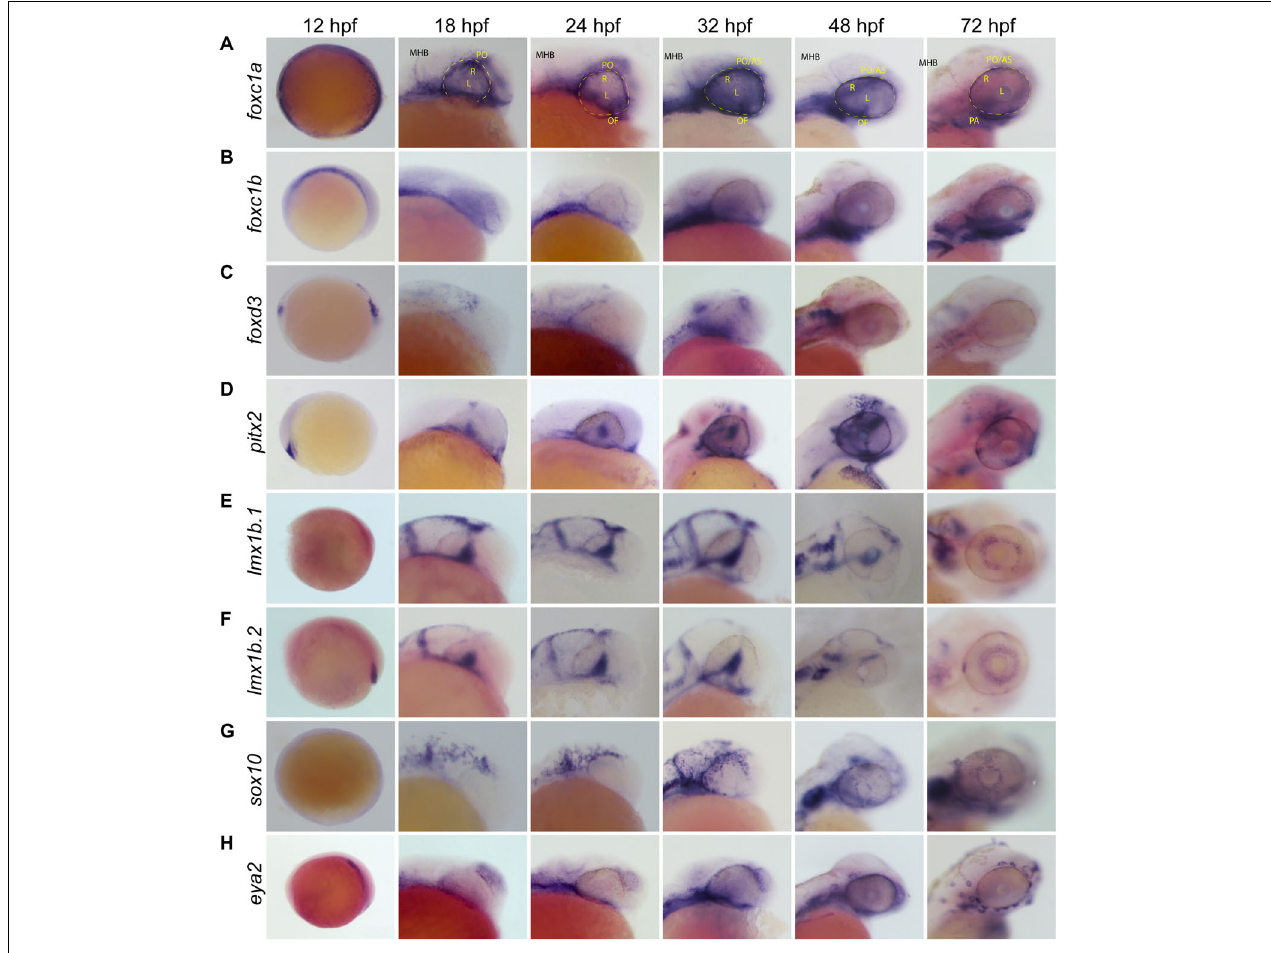
FIGURE 1 | Whole Mount In Situ Hybridization (WISH) of known POM and neural crest-related marker genes. Whole-mount in situ hybridization for POM marker gene mRNA expression patterns were observed during early to late stage eye development in the lateral view. POM genes examined were (A) foxc1a , (B) foxc1b , (C) foxd3 , (D) pitx2 , (E) lmx1b.1 , (F) lmx1b.2 , (G) sox10 , and (H) eya2. Foxc1a , foxc1b , pitx2 , eya2 , and sox10 in particular show strong expression surrounding the optic cup and on the surface of the anterior segment from 24 to 72 hpf. Lmx1b.1 and lmx1b.2 expression is detected within the anterior segment, surrounding the lens by 48–72 hpf. MHB, midbrain-hindbrain boundary; R, retina; L, lens; OV, optic vesicle; PO, periocular space (outlined with dashed line); OF, optic fissure; AS, anterior